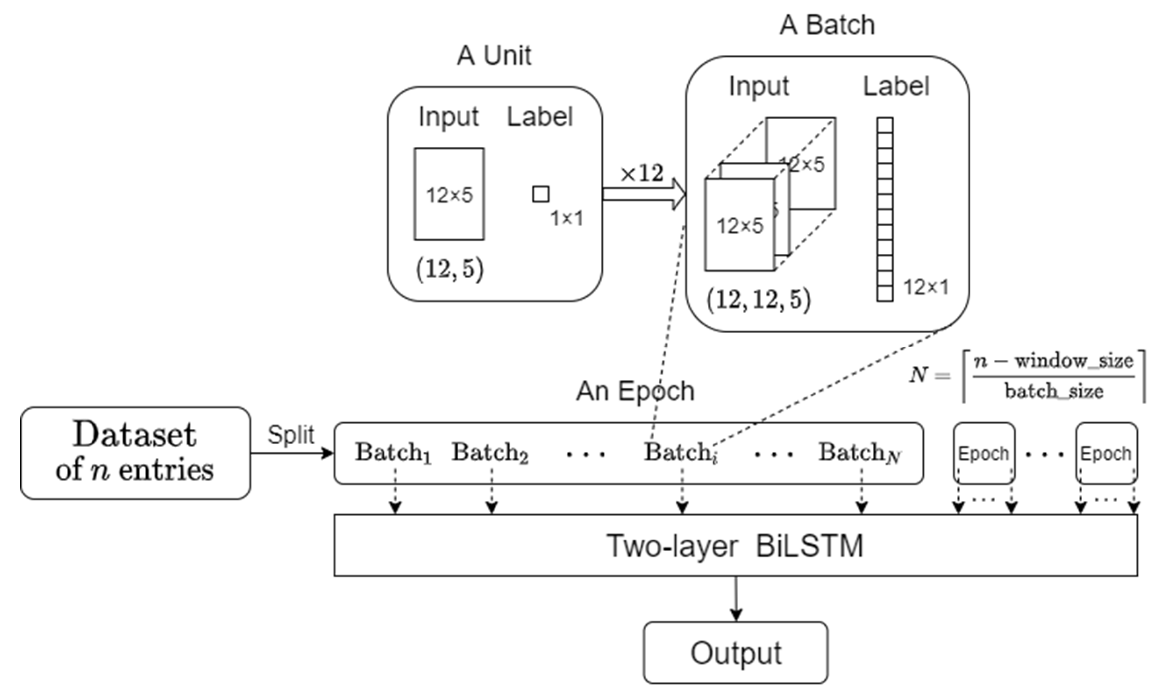
Figure 6. BiLSTM work flow chart.